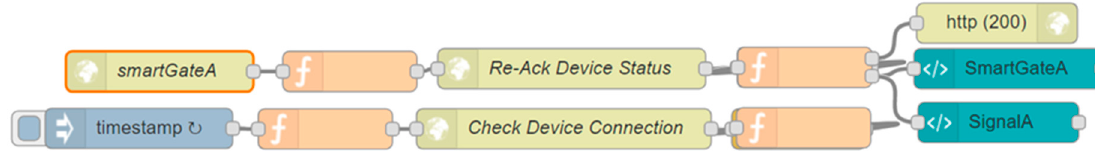
Figure 12. The local supervisor interface in case of inconsistency and following a connection problem with the smart gate A.